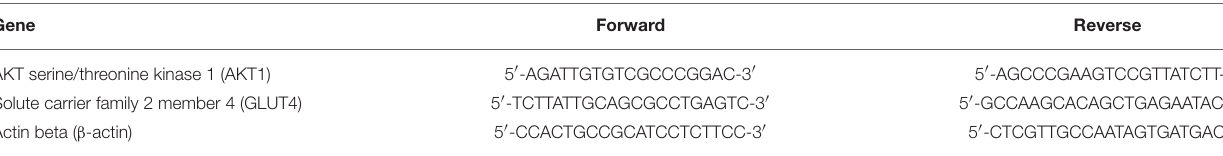
TABLE 1 | Premier sequences for real-time PCR. Gene